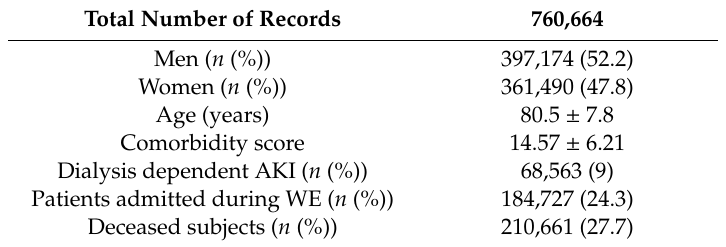
Table 2. Demographic features of the considered sample (AKI: acute kidney injury, WE: weekend e ff ect).